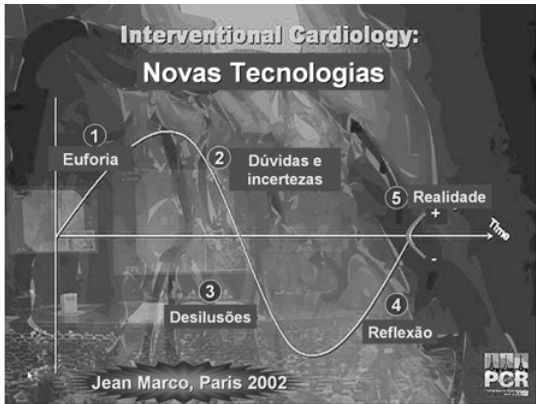
Fig. 1 - Fases de incorporação de novas tecnologias